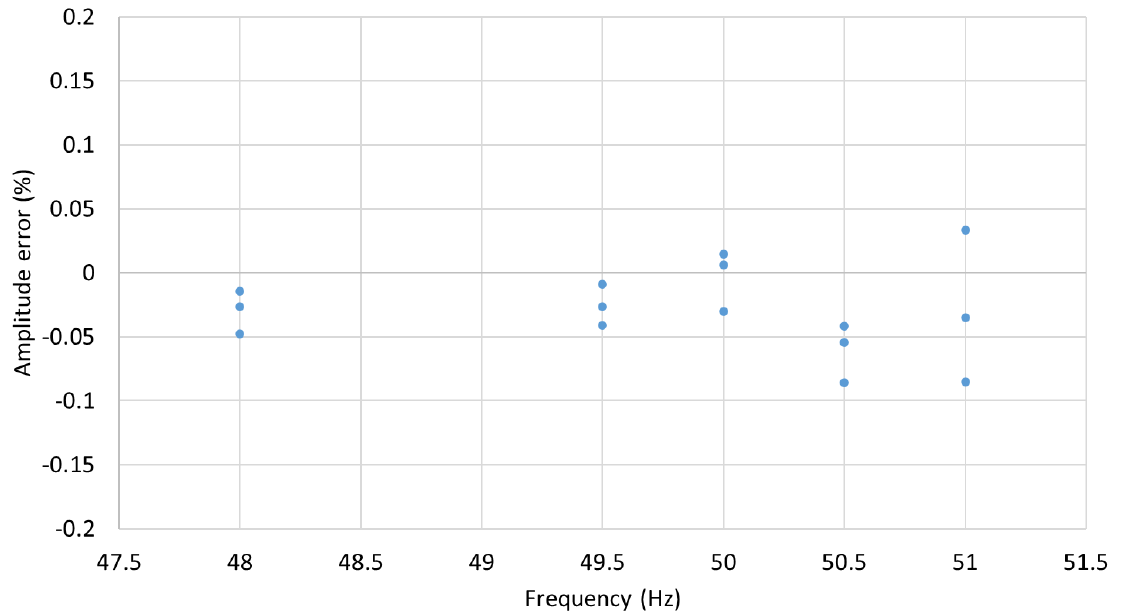
Figure 10. MVT voltage amplitude errors at nominal voltage and frequencies 48, 49.5, 50.5, 51 Hz.